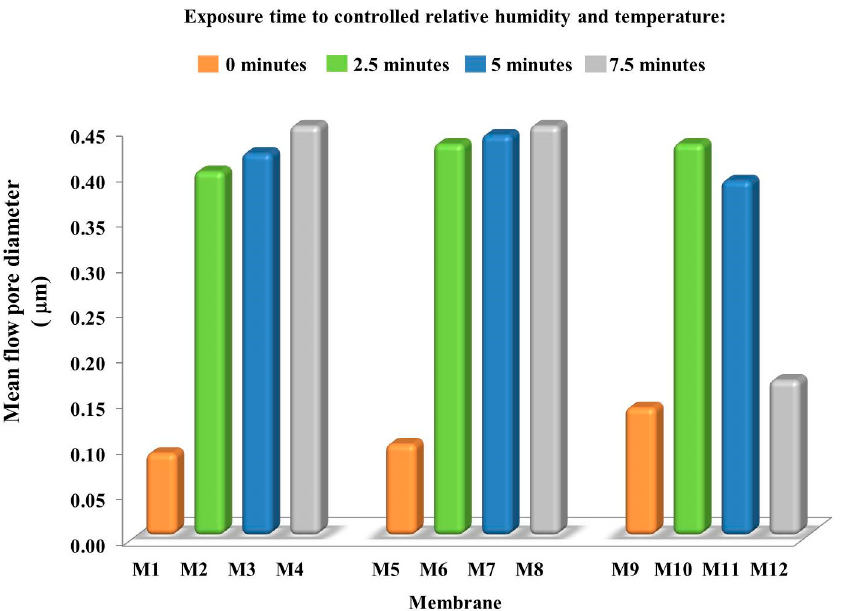
Figure 3. Mean flow pore diameter of the prepared membranes (in all cases, the relative standard error was less than 5%).